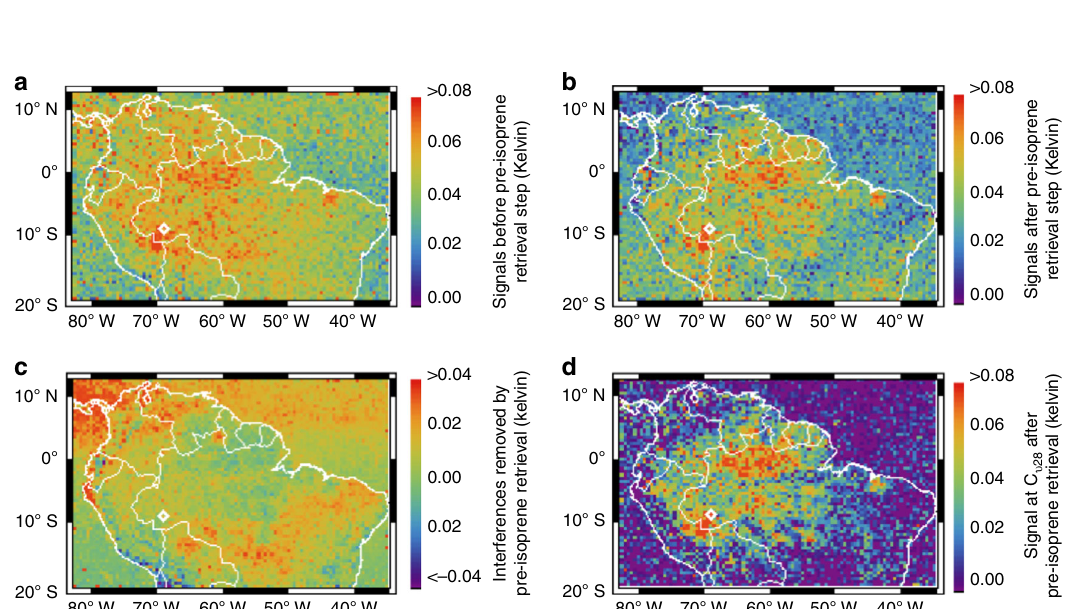
Fig. 3 Isoprene spectral signal in CrIS measurements over Amazonia during September 2014, mapped on a 0.5° × 0.5° latitude – longitude grid. a Measured on-peak vs. off-peak brightness temperature differences ( Δ T b ) between the C off and C ν 28 spectral channels before the pre-isoprene retrieval step. b Measured Δ T b between the C off and C ν 28 spectral channels after the pre-isoprene retrieval step. c Difference between panels a and b illustrating the interferences that are accounted for by the preisoprene retrieval step. d Brightness temperature difference Δ T ν 28 at the C ν 28 spectral channel between the CrIS-measured radiances and the model-simulated radiances from the pre-isoprene retrieval step, illustrating the spectral signal due to part of Peru). The DOFS range from approximately 0.5 – 1 over depths of up to ~0.6 – 0.7 that are associated with weak arti fi cial areas with elevated isoprene (Fig. 5b). The observed spatial enhancement in the retrieved isoprene columns. A more stringent distribution of isoprene diverges signi fi cantly from the a priori cloud threshold would reduce such effects, and could be (Fig. 5c, Supplementary Fig. 2), re fl ecting the information content employed in postretrieval analysis. of the CrIS observations. Figure 5e, f map the total a posteriori retrieval uncertainty, including contributions from spectral noise, interferences, and smoothing errors. Values shown represent the mean across all CrIS measurements within a grid cell, and are dominated by smoothing errors — as expected given the DOFS and total column retrieval approach. The estimated uncertainty of a single-retrieval is generally ~0.25 × 10 16 molecule cm − 2 (Fig. 5f). The single- retrieval 3 σ detection limit is ~0.8 × 10 16 molecule cm − 2 . How- ever, the random component of this uncertainty is strongly reduced by averaging given the dense spatial sampling provided by the CrIS instrument (Fig. 5h). We note that a posteriori uncertainties such as the above can underestimate the true measurement error, as they do not account for possible systematic errors in the retrieval framework (e.g., associated with the absorption cross-sections), and also depend on the prescribed a priori errors. As a result, retrieval evaluation against independent